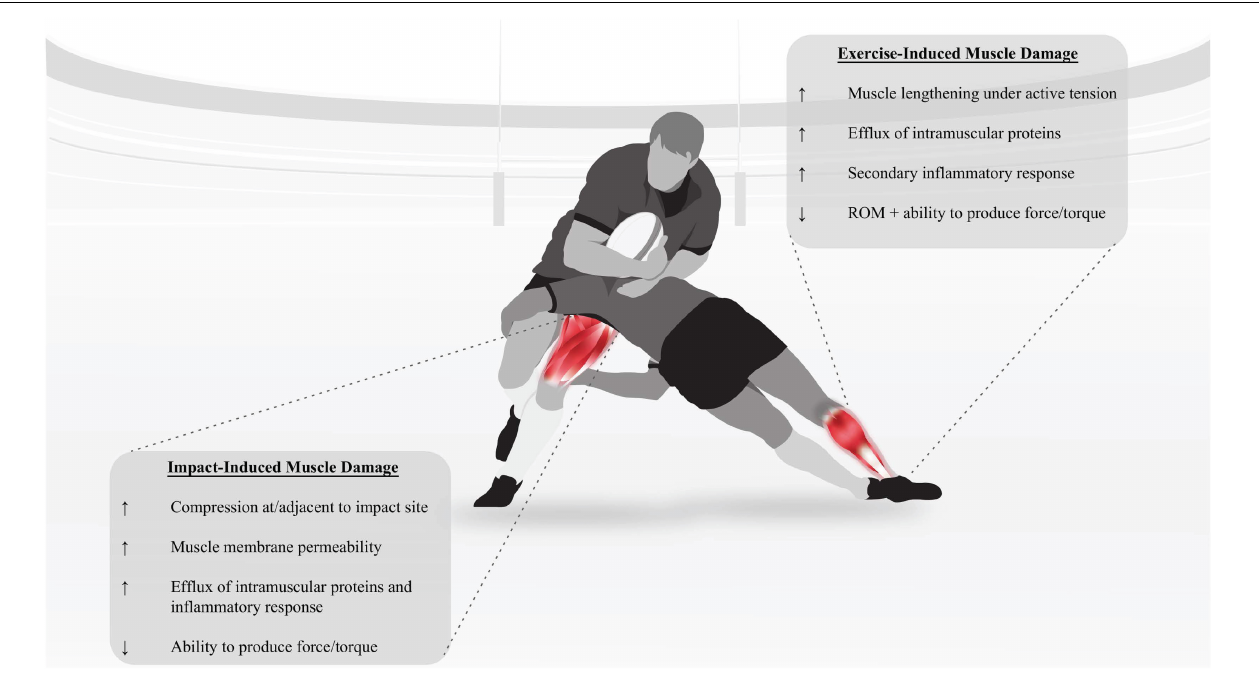
FIGURE 1 | A graphical representation of a rugby collision and its relationship with exercise induced muscle damage (EIMD) (tackler) and impact-induced muscle damage (IIMD) (ball carrier), including the purported effects of EIMD (McHugh et al., 1999; Clarkson and Hubal, 2002; Peake et al., 2005, 2016; Howatson and Van Someren, 2008; Chazaud, 2016), and IIMD (Takarada, 2003; Järvinen et al., 2005; Lindsay et al., 2015b; Naughton et al., 2018). ROM, range of